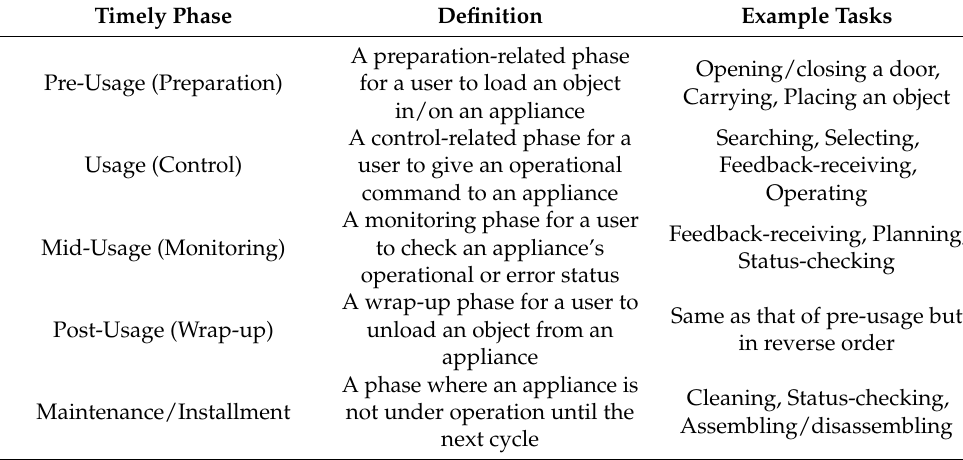
Table 1. Definitions and examples of timely phase when using home appliances.